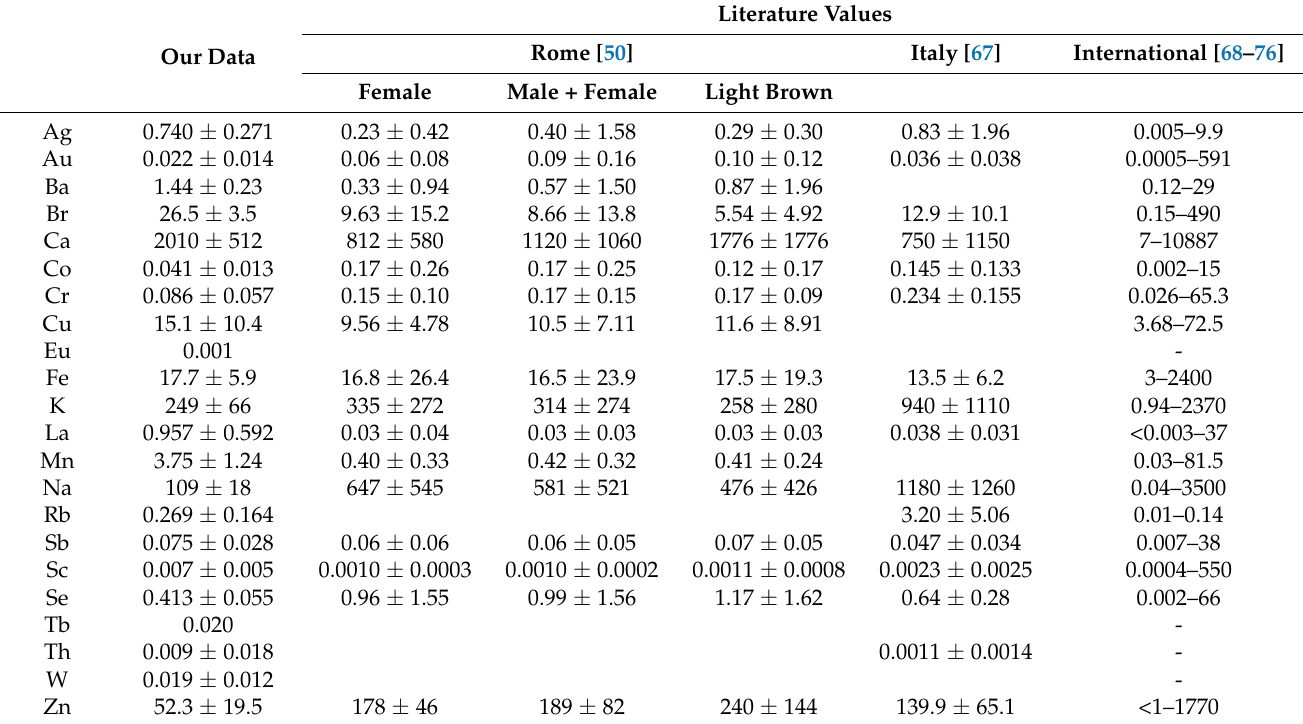
Table 4. Concentration ( µ g g − 1 ) comparison between these data and those found in other Italian and international studies.